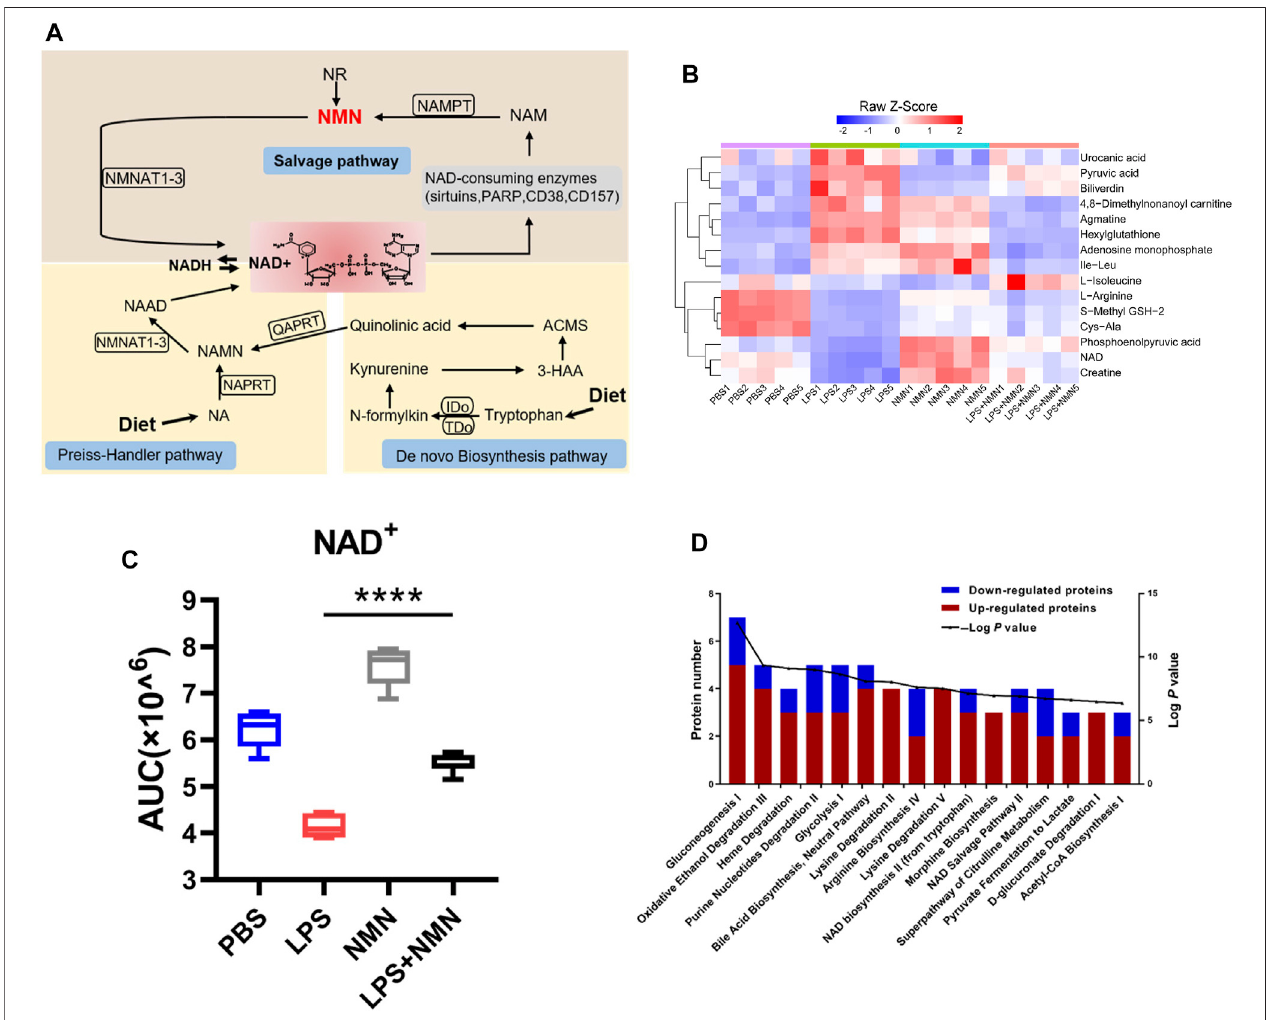
FIGURE 2 | NMN supplementation increased cellular NAD + levels. (A) A schematic view of NAD + biosynthesis. (B) Heatmap clustering analysis of 15 metabolites whoseexpressionswereantagonizedbyNMNinLPStreated-macrophages( > 1.33-foldor < 0.75-fold; p -value < 0.05). (C) ChangesinNAD + levelsinLPS-,NMN-,LPS/ NMNco-treatedgroupsfromthemetabolomicsdata(**** p < 0.0001,** p < 0.01,* p < 0.05, n (cid:2) 5,mean ± SEM). (D) Ingenuitypathwayanalysis.Theredbarrepresented the number ofincreasedmetabolites, and while theblue representedthe number ofdecreasedones indifferentbiologicalprocesses. (LPS/NMN co-treated group versus LPS treated group > 1.33 or < 0.75-fold, P <